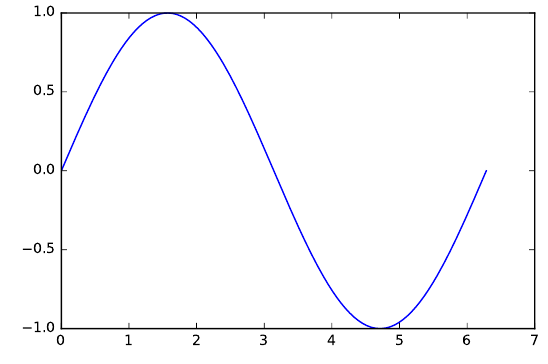
Fig. 82.— Plotting a sine function with matplotlib